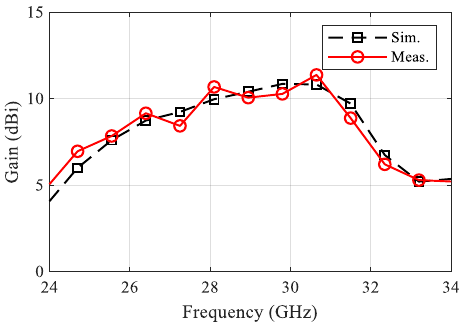
Figure 14. Measured and simulated gain versus frequency.